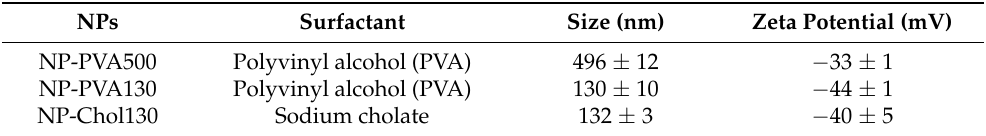
Table 1. Types of NPs used in our